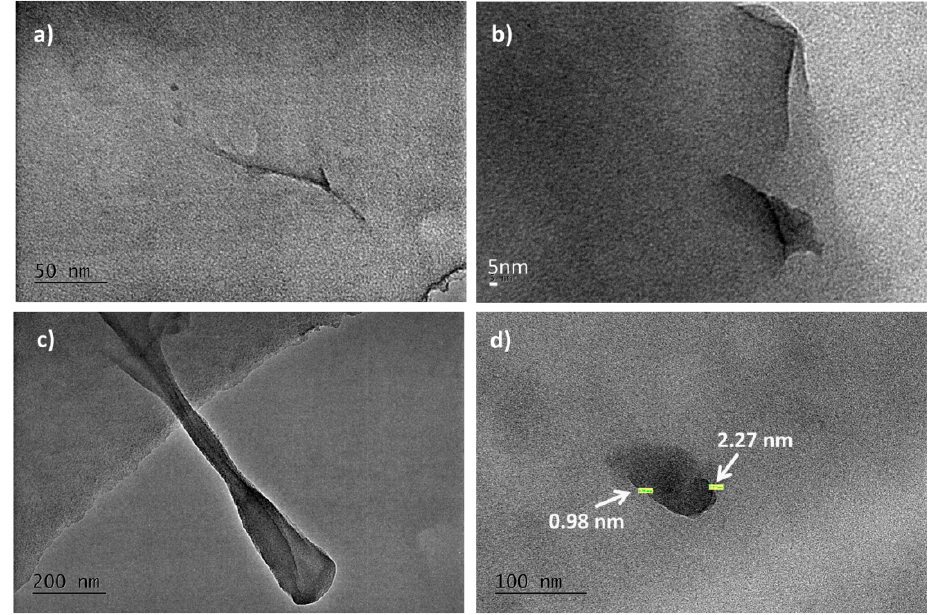
Figure 8. Transmission electron microscopy (TEM) images of PS-CNWs-3% nanocomposite ( a – d ).